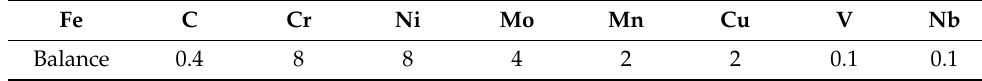
Table 1. Nominal composition of experimental maraging steel (wt.%). Figure 1. The plate after the welding treatment is completed, where HS, FC and FS stand for heter- ogeneous structure, freestanding center coarse and freestanding surface, respectively.